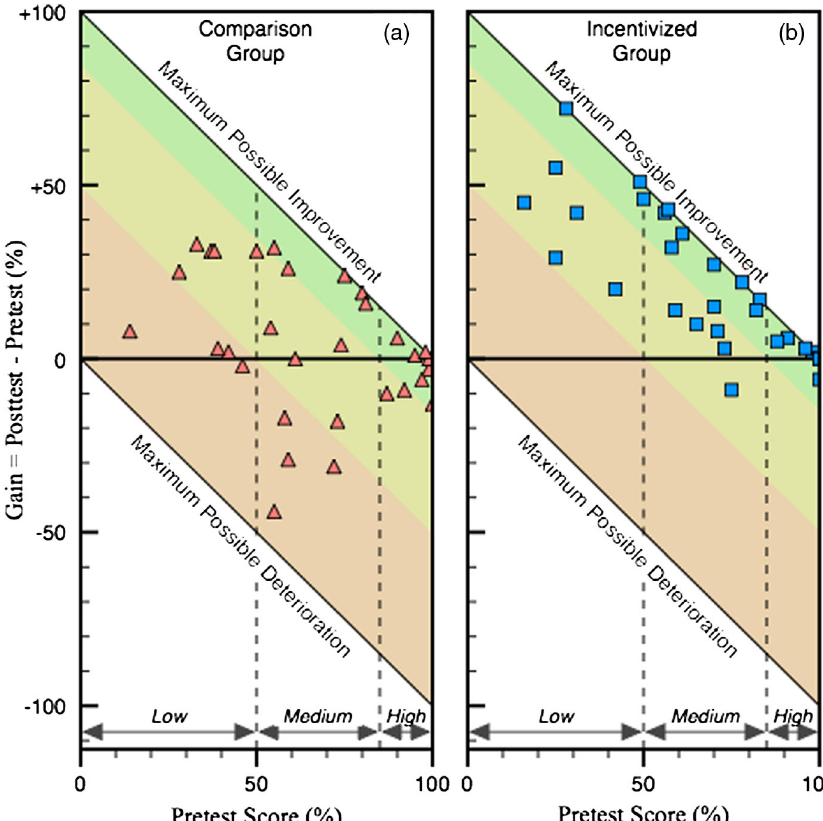
FIG. 1. Average gain (defined as the difference between posttest and pretest score) vs pretest score for each student on the four questions repeated from the pretest to the posttest in the comparison group (A) and incentivized group (B). Red-filled triangles are for each student from the comparison group and the blue-filled squares are for each student in the incentivized group in which students received an explicit grade incentive to correct their own mistakes in the pretest before answering the same questions on the posttest. Students whose scores improved are above the horizontal axis; students whose performance deteriorated are below the horizontal